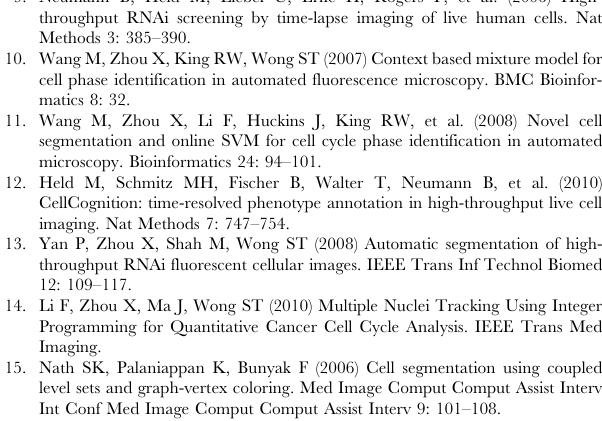
Figure S4 Time Series Analysis algorithm. ( a ) Flow chart displaying the algorithm used to identify interphase-prophase transition (IPT) and metaphase-anaphase transition (MAT) points